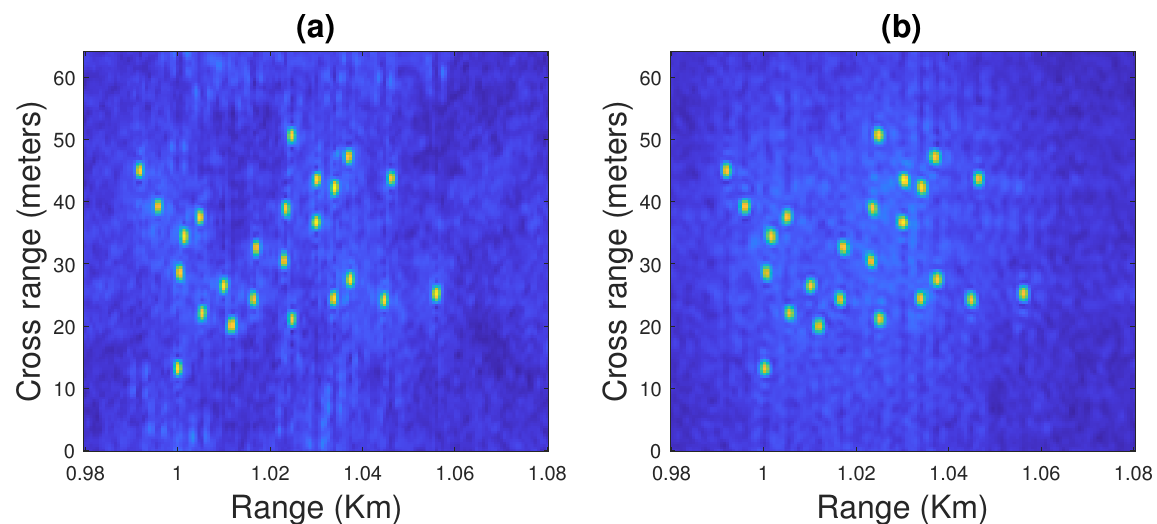
Figure 16. Ambiguity surface of the monostatic radar for ( a ) the Lorenz CBFM waveform and ( b ) the Burke–Shaw CBFM waveform.